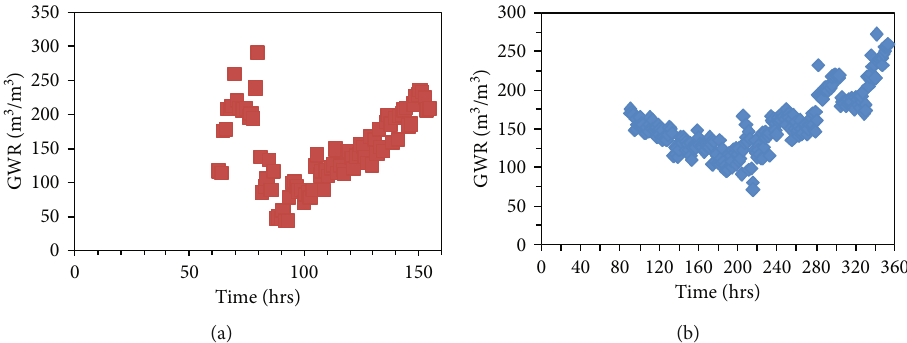
Figure 3: Diagnostic plots for two wells in shale gas formations belonging to southern Sichuan. (a) GWR plot for Well 3. (b) GWR plot for Well